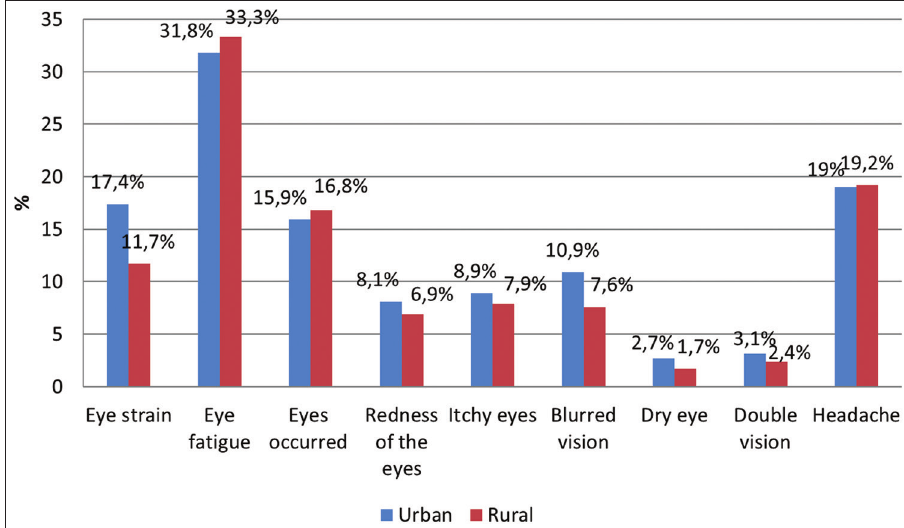
CHART 1. Presentation of eye symptoms during or after using the ICT devices per regions.